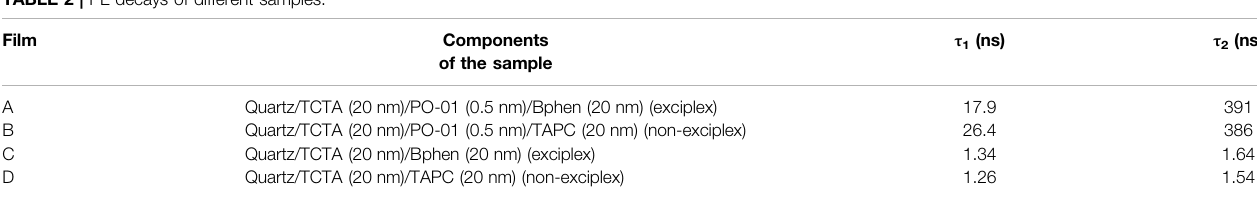
TABLE 2 | PL decays of different